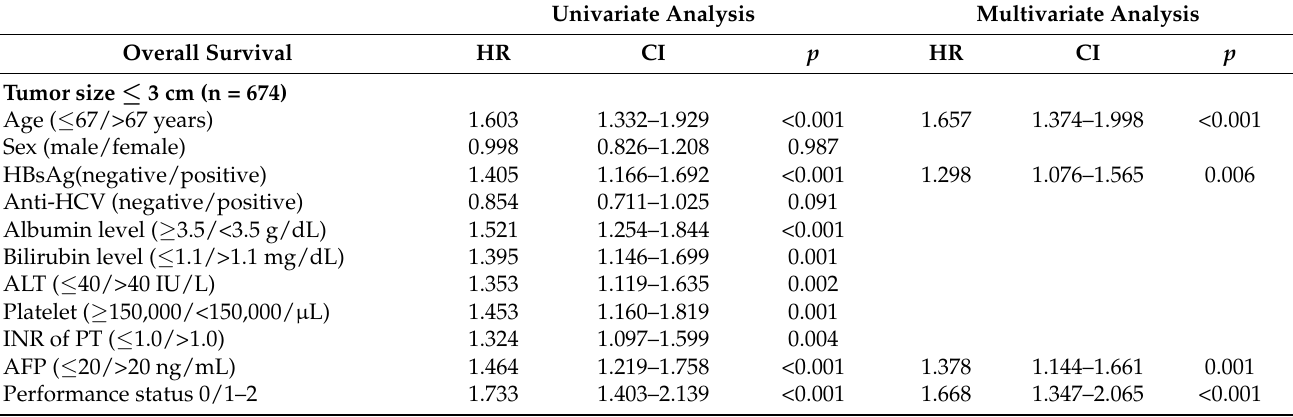
Table 5. Multivariate Cox analysis in HCC patients with tumor size ≤ 3 cm and >3 cm undergoing RFA or TACE. Univariate Analysis Multivariate